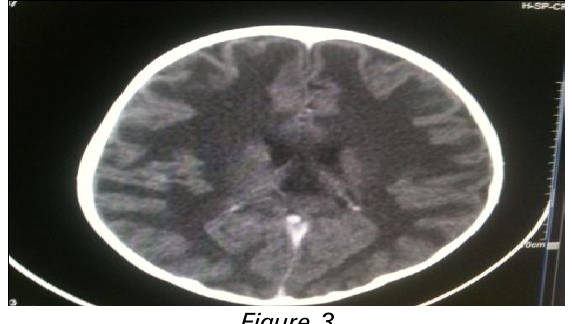
Figure 1, 2 & 3: Post contrast axial CT scan images